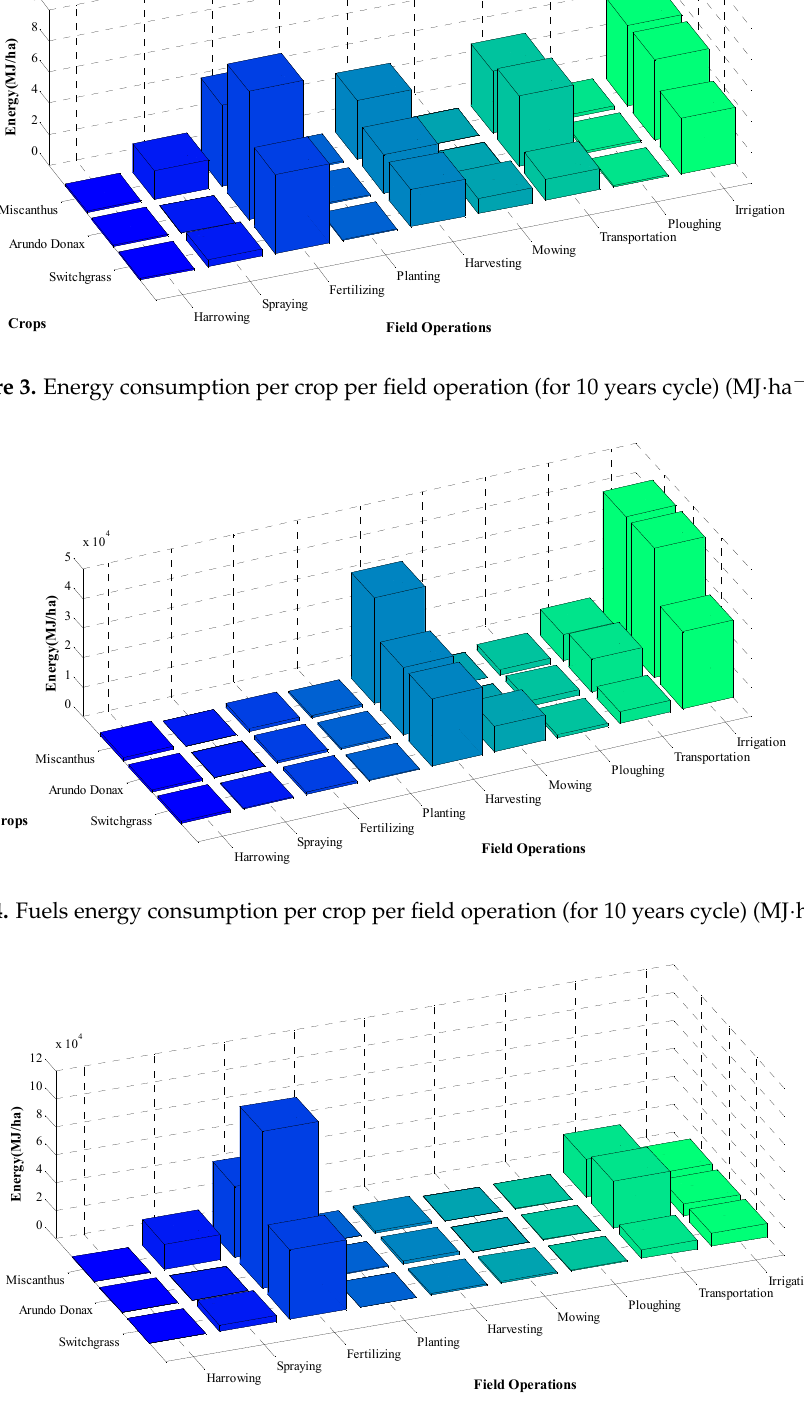
Figure 5. Embodied energy consumption per crop per field operation (for 10 years cycle) (MJ·ha − 1 ).